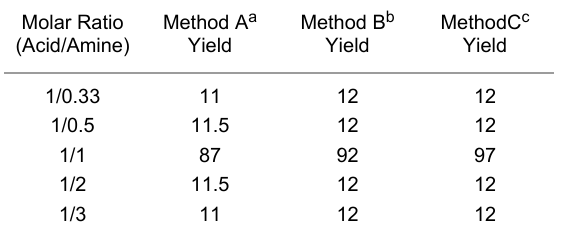
Table 4: Effect of the molar ratio using 20 mg of enzyme at 60 °C.